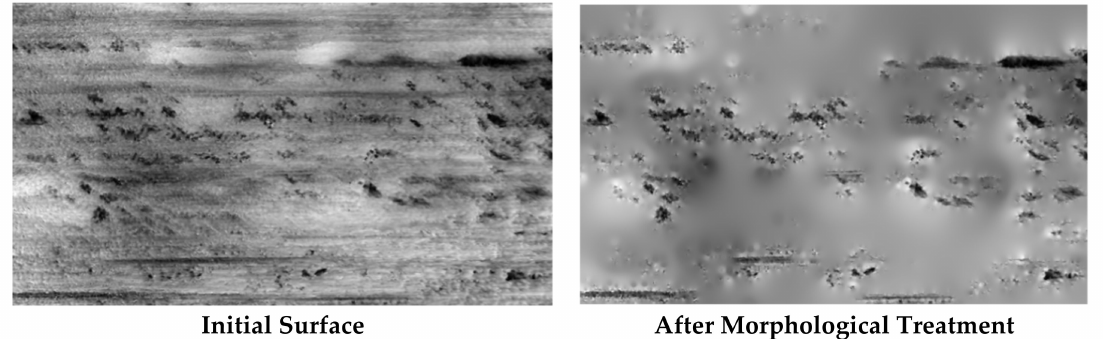
Figure 19. Morphological surface transformation according relevance of the